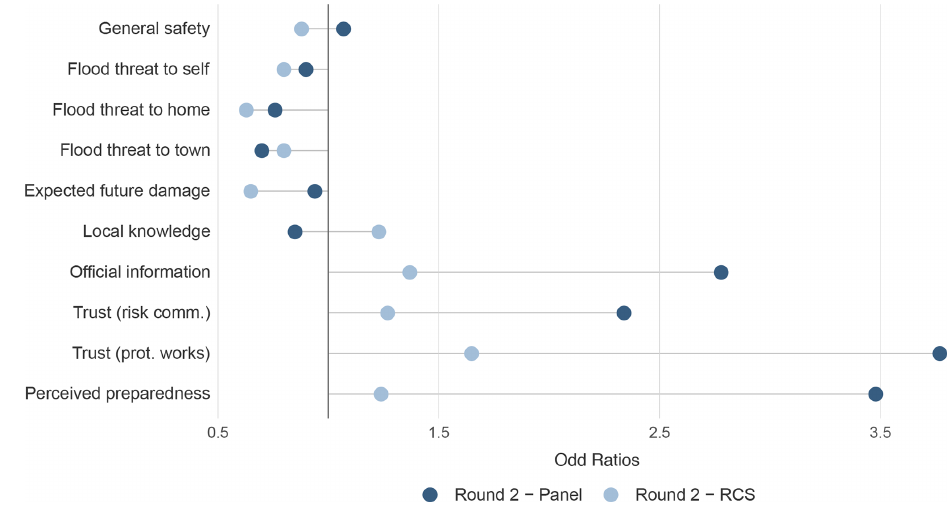
Figure 1. Comparison of results from the two approaches on the effect of time on the variables of